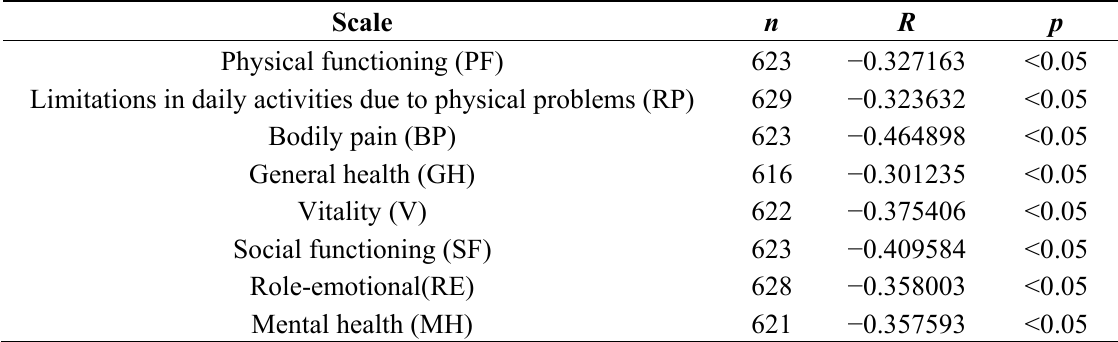
Table 8. Correlations between quality of life according to the SF-36 and severity of climacteric symptoms according to the Blatt-Kupperman Menopausal